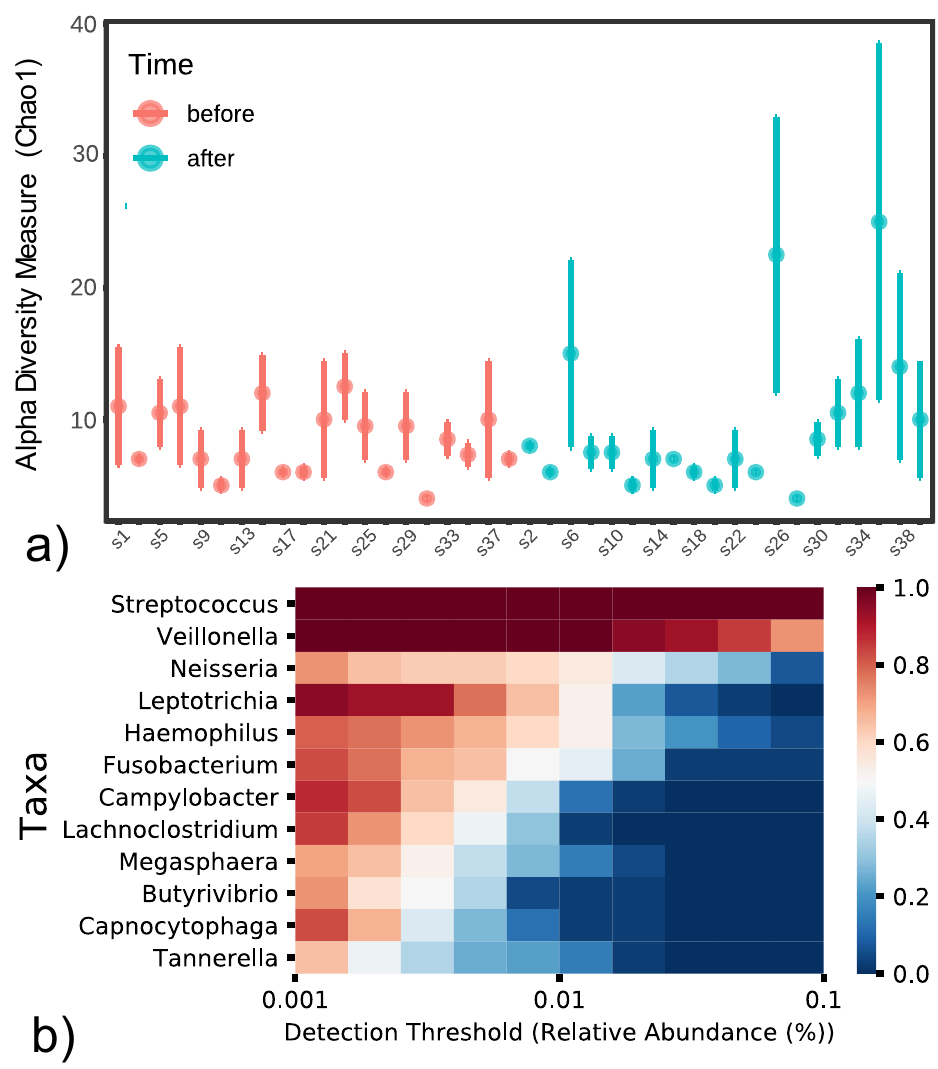
Figure 2. Changes in salivary microbiome before and after anticancer treatment: ( a ) Alpha diversity measures for matched patient samples (PAT(#ID)(before/after)) using Chao1 index (red—before, blue—after); ( b ) Heatmap of taxon prevalence by its relative abundance, cell color represents a relative prevalence of taxa at certain detection threshold (from 0 to 1, blue to red).